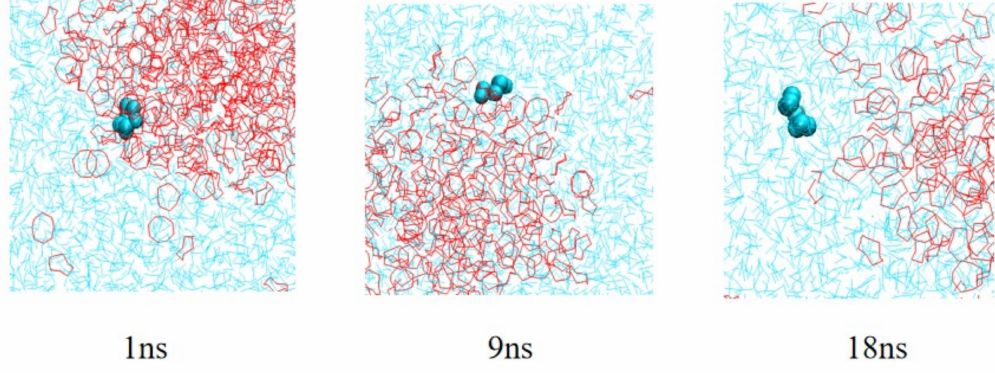
Figure 7. Partial enlargement of single S 8 molecule dissolved in CS 2 system (cyan is single S 8 molecule, light blue is CS 2